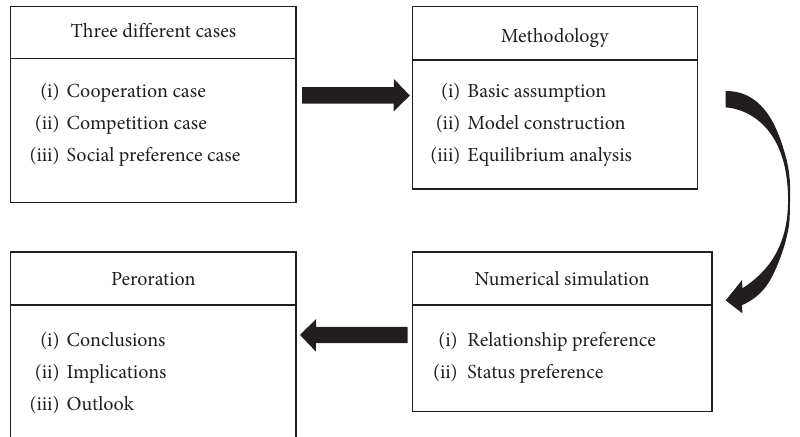
Figure 1: Te framework of this